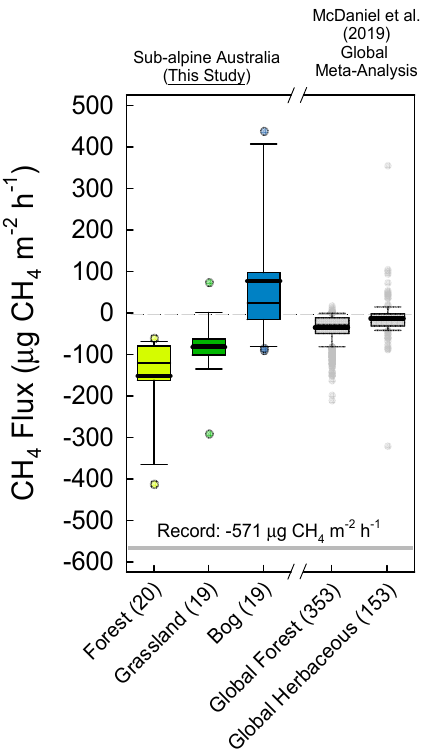
Figure 8. Hourly CH 4 fluxes from this study’s forest, grassland and bog (from Figure 3A–D) soils compared to forest and herbaceous studies from a global meta-analysis [90]. The 10th and 90th percentiles are shown by bottom and top whiskers. The 25th and 75th percentiles are shown by the bottom and top of the box. Median is shown by the thin line, mean by the thick line, and outliers are circles. The number of measurements within each boxplot are shown in parentheses. Gray bar at − 571 µ g CH 4 m − 2 h − 1 is the greatest CH 4 oxidation rate (most negative flux) ever observed and published [91].